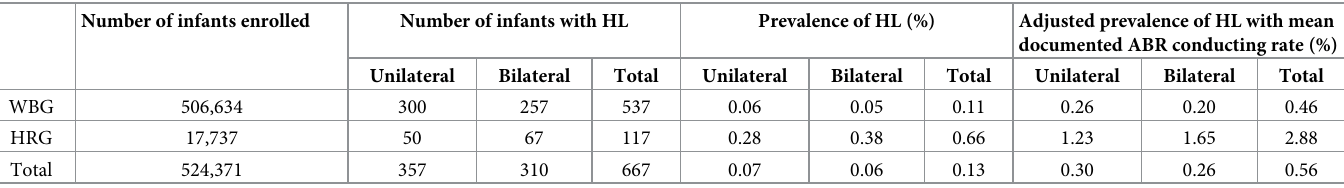
Table 4. Prevalence of hearing loss (HL) in the WBG and HRG in 9 years of newborn hearing screening pilot program in Korea. Number of infants enrolled Number of infants with HL Prevalence of HL (%)